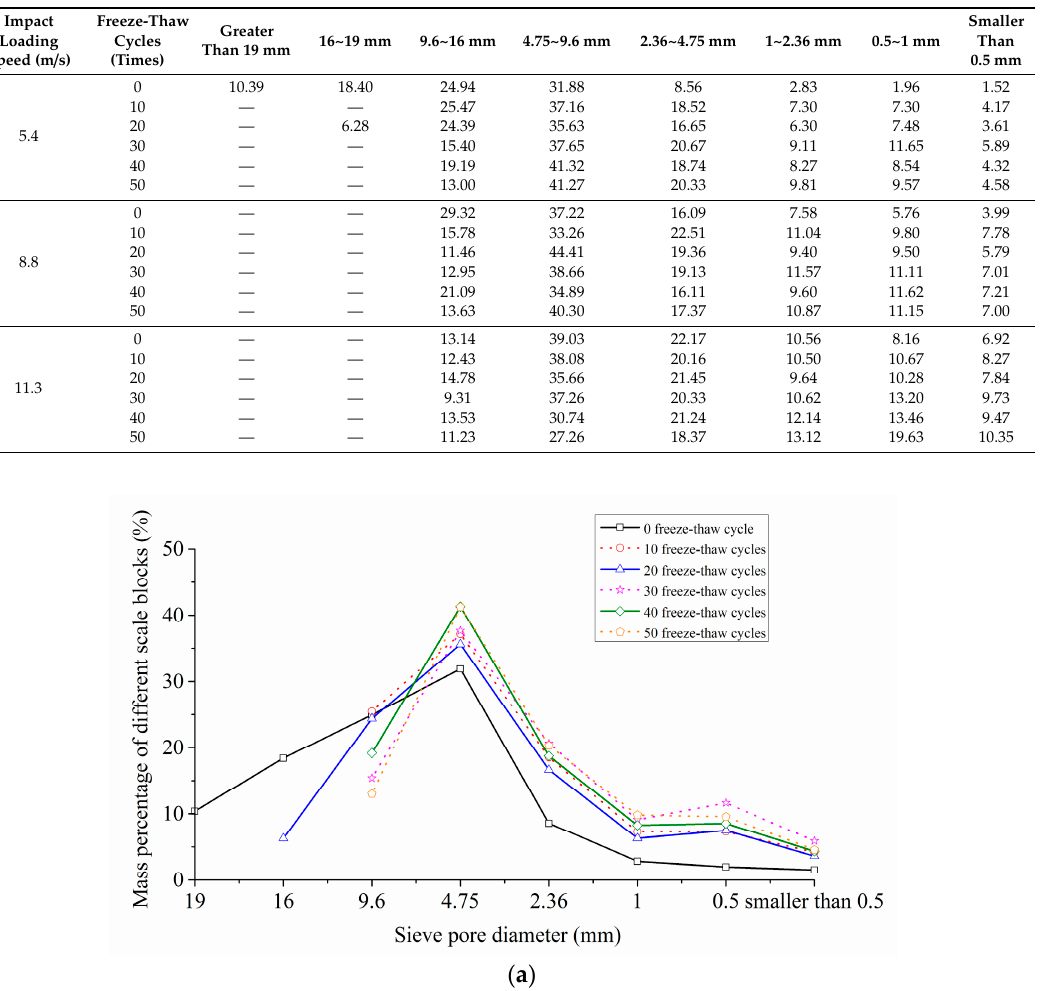
Table 5. Mass percentage of each particle size under different